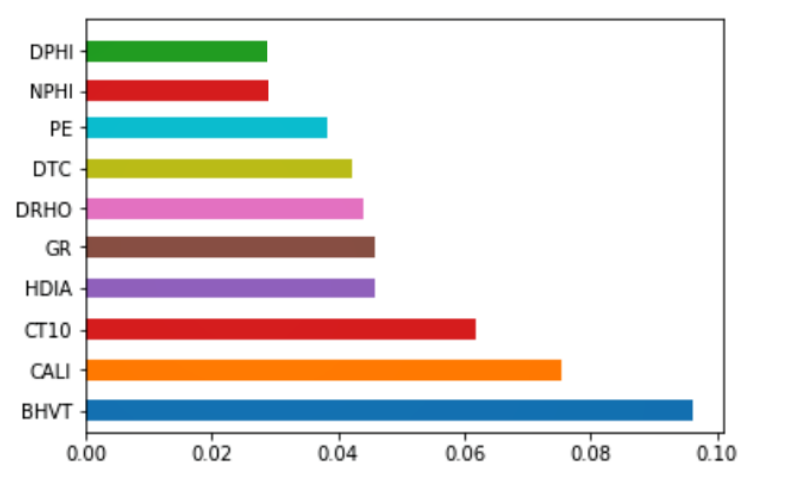
Figure 1. Feature importance.